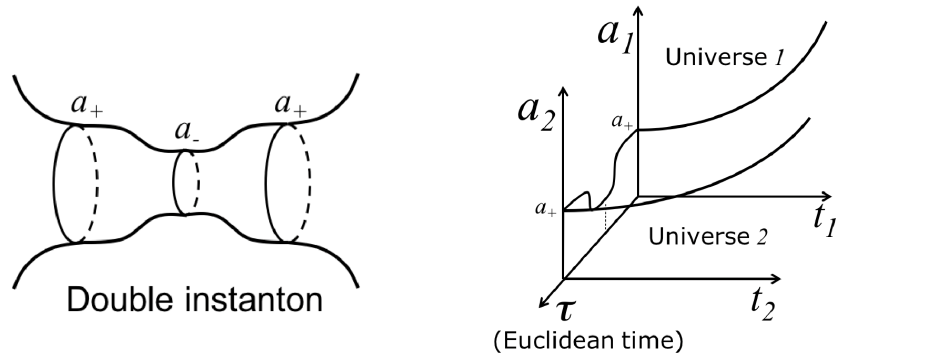
Figure 12. ( Left ) a double Euclidean instanton can be formed by matching two single Euclidean instantons. ( Right ) The creation of a pair of entangled universes from nothing , i.e., from a double Euclidean